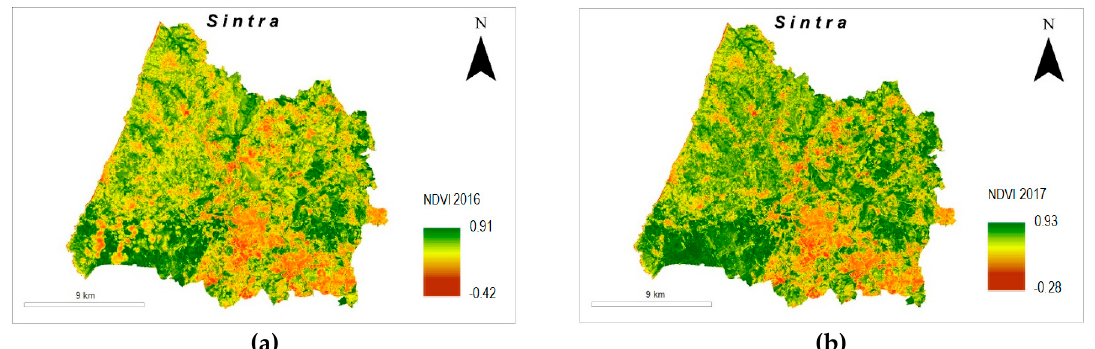
Figure 8. NDVI maps of Sintra for: ( a ) prefire and ( b ) postfire derived from the Landsat 8 data (adapted from [44]).